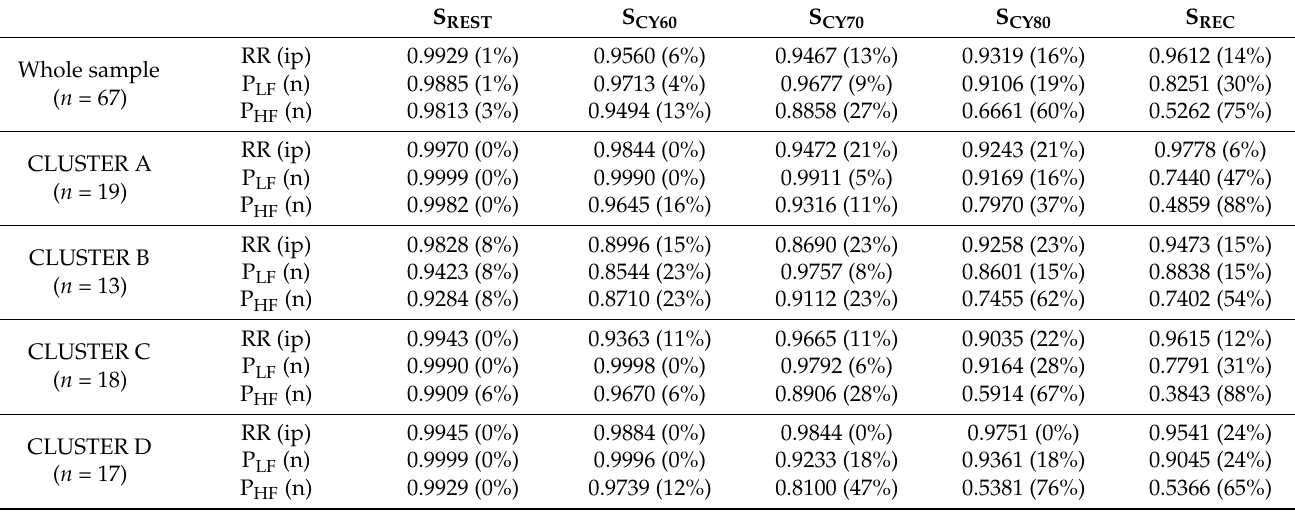
Table 4. Agreement between devices in: RR (ip), PLF (n) and PHF (n). CCC mean and percentage of subjects not reaching excellent agreement for each